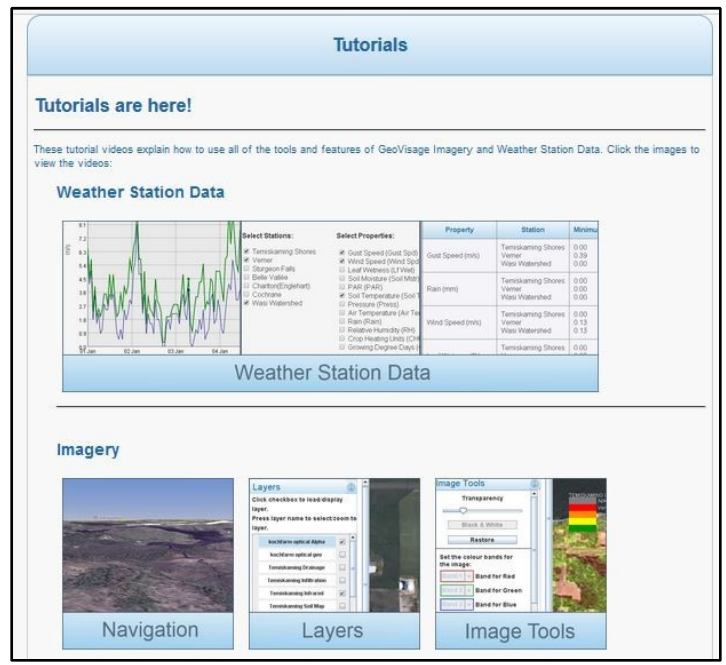
Figure 8. GeoVisage online video tutorials screen-capture.